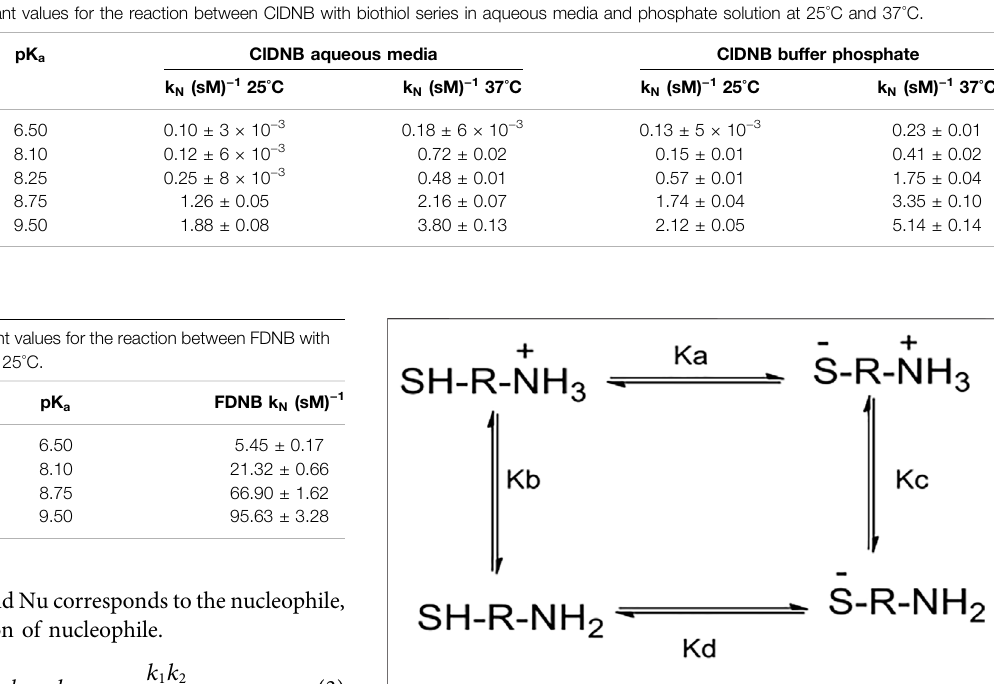
FIGURE 6 | Acid – base equilibria related to general aminothiol in the pH range between 6 and 12. K a – K d are the macroscopic constants for each equilibrium (Sardi et al., 2013; Calfumán et al., 2017).